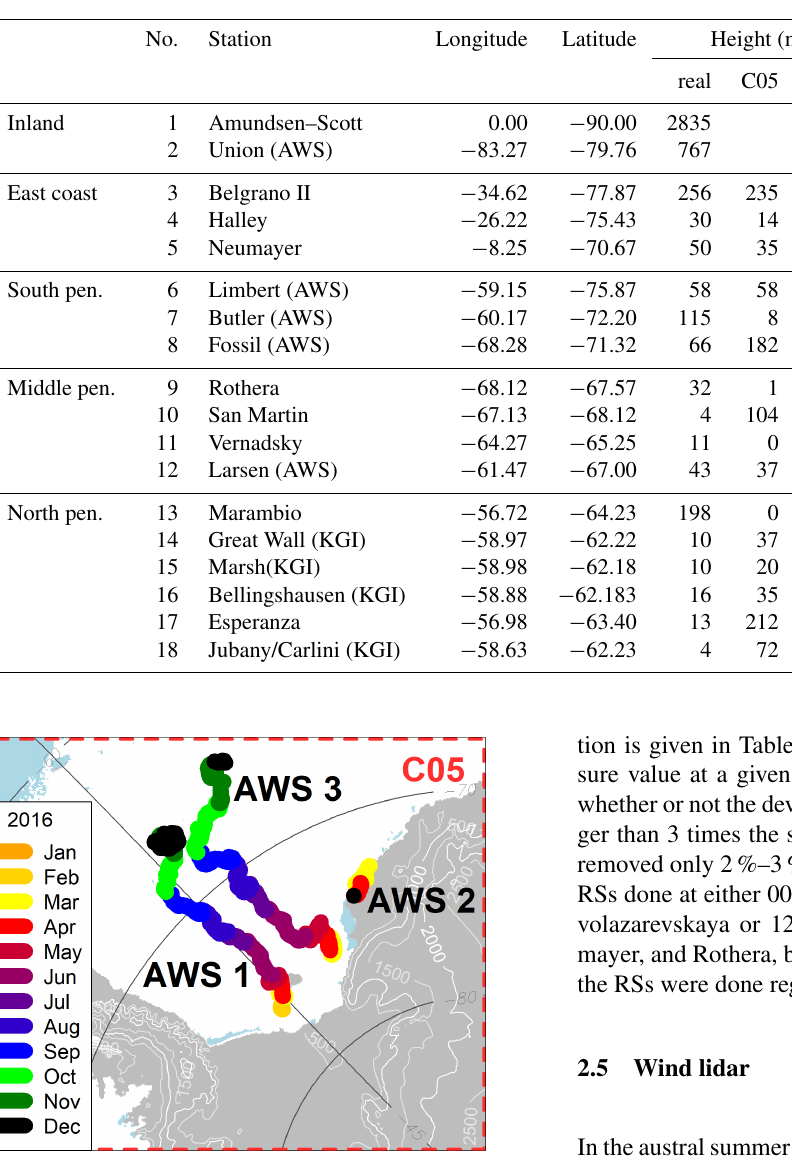
Figure 2. Overview of tracks of the three AWS buoys inside the C05 domain. Topography and sea ice concentration as in Fig.